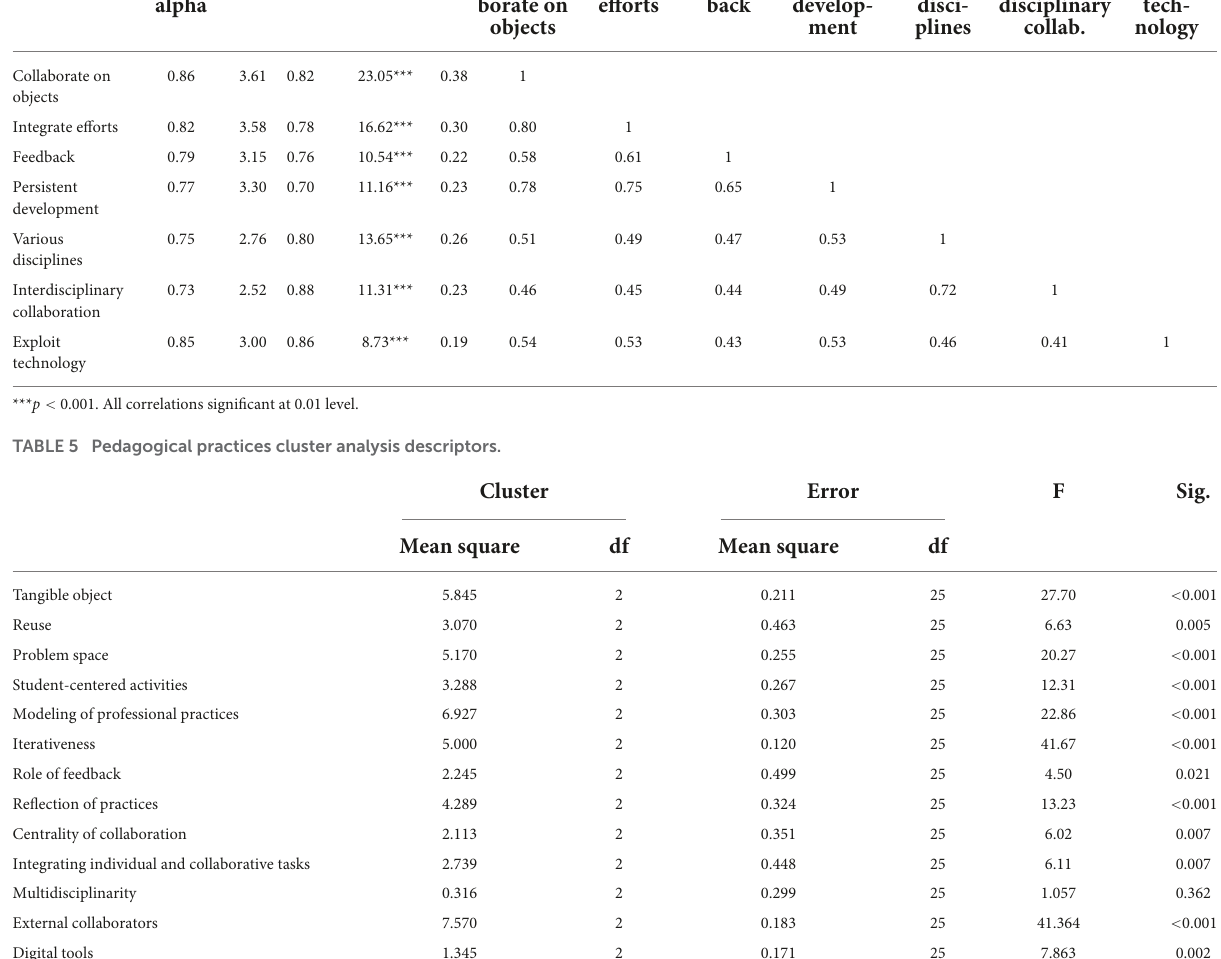
TABLE 4 Collaborative knowledge practices scale reliabilities, one-way analyses of variance, and correlations. Scale